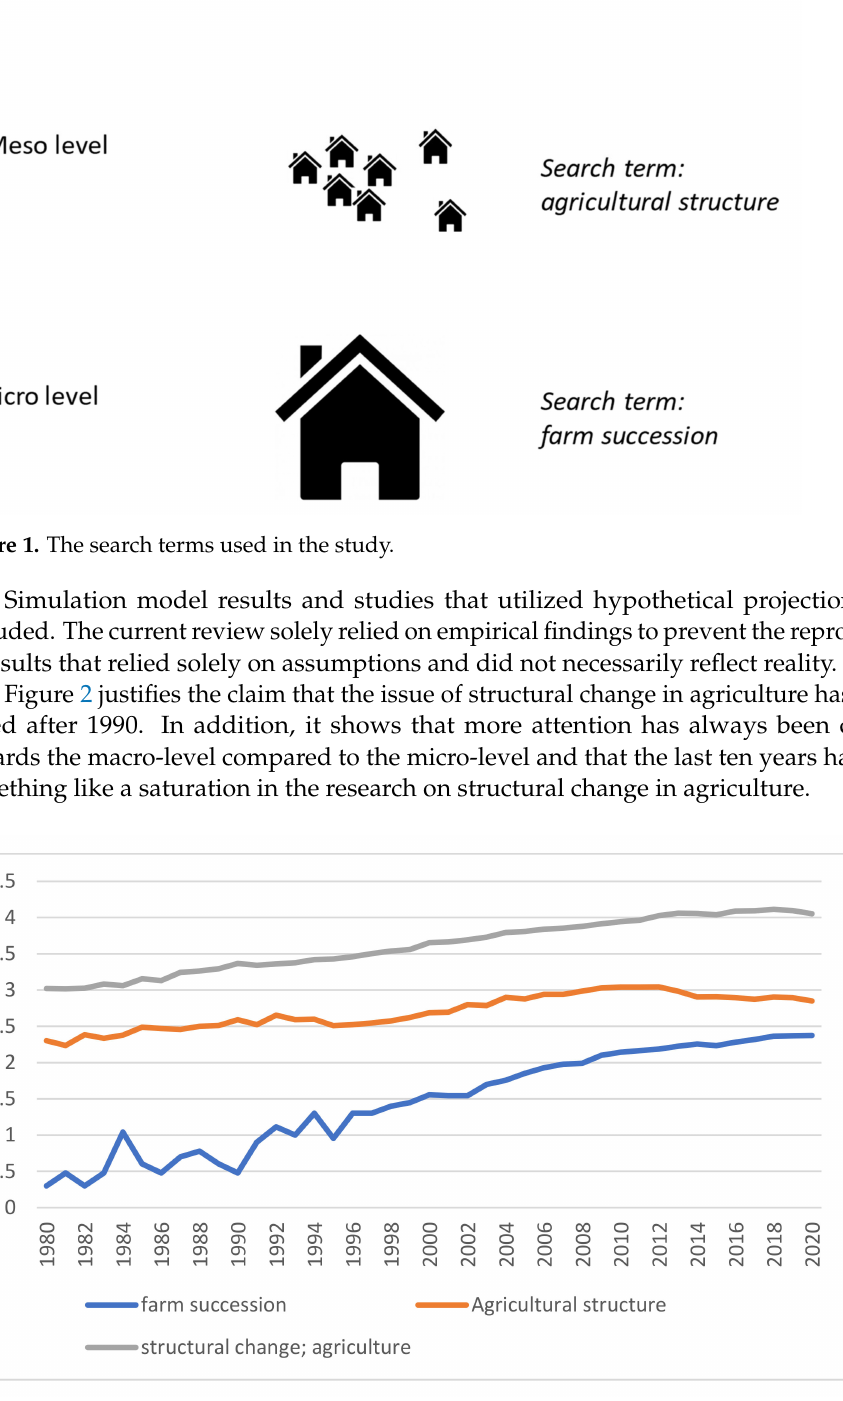
Figure 2. Log-scale search results in scholar.google.com for the three search terms, by year (source: own